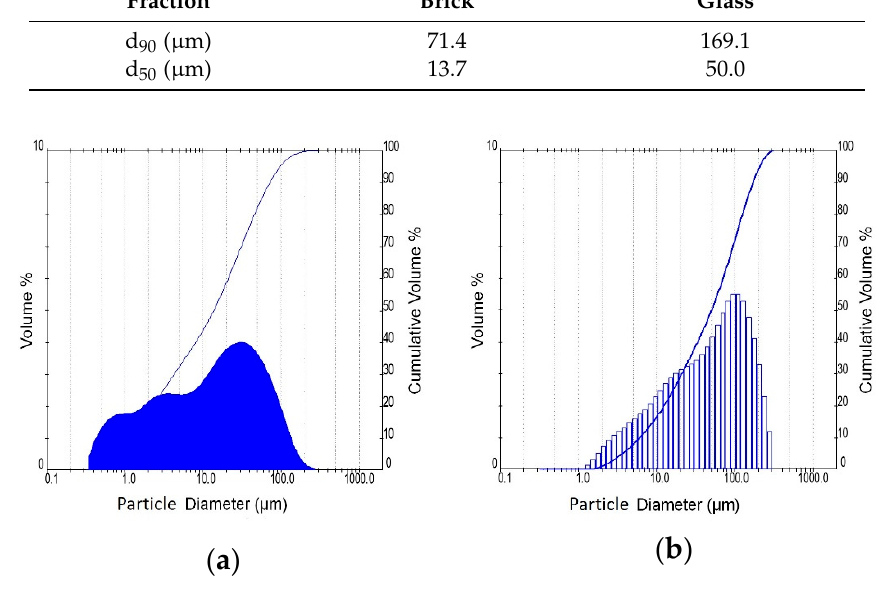
Figure 1. Particle size distribution of brick ( a ) and glass ( b ).